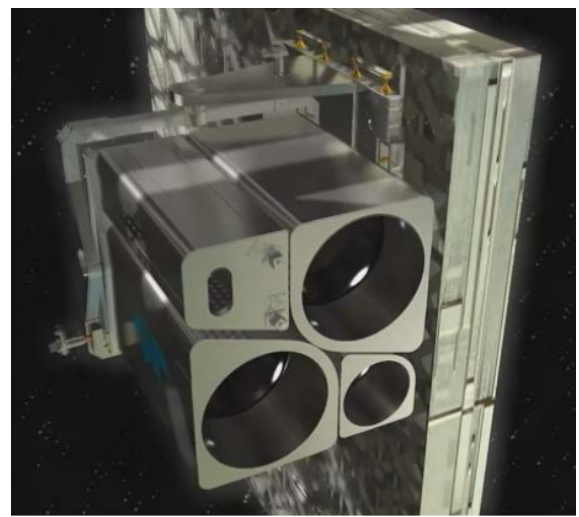
Figure 1. Multi-User System for Earth Sensing (MUSES) platform with the two small and two large slots for payloads. DESIS will be located in one of the large slots.